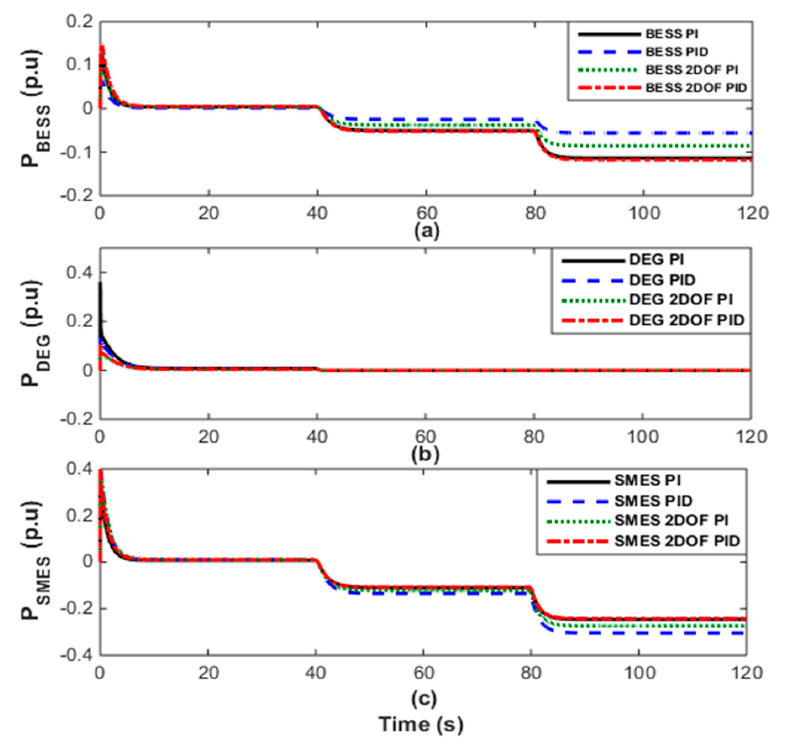
Figure 10. Power-sharing of the ( a ) BESS, ( b ) DEG, and ( c ) SMES in case3. The optimized gain values of the PI, PID, 2DOF PI, and 2DOF PID controllers attained using the FPA are displayed in Tables 5–8, respectively. The maximum changes in the frequency fluctuations ( ∆ f in Hz) of the hybrid response model for different operating conditions are shown in Table 9.